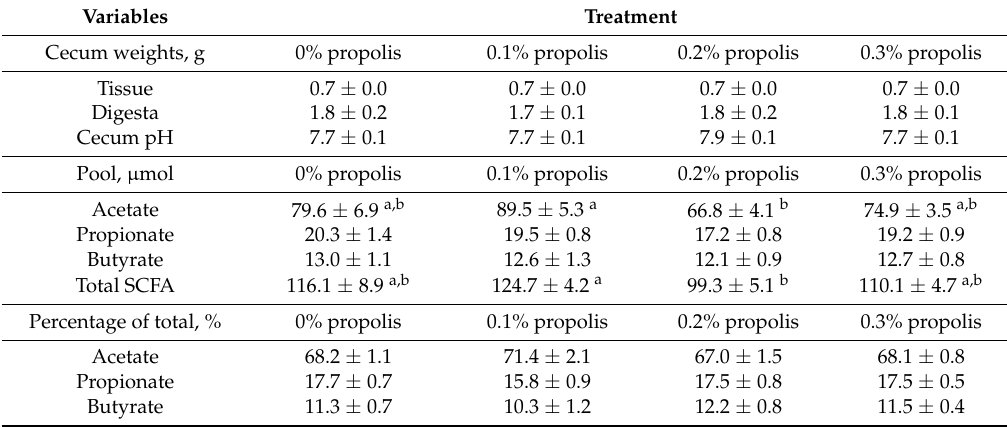
Table 3. Effects of propolis administration on individual and total SCFA levels in caecal digesta of DSS-induced colitis rats 1